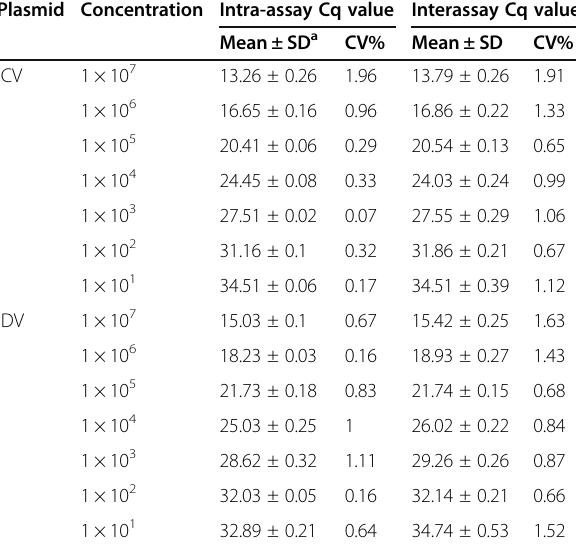
Table 4 Repeatability results of duplex real-time PCR